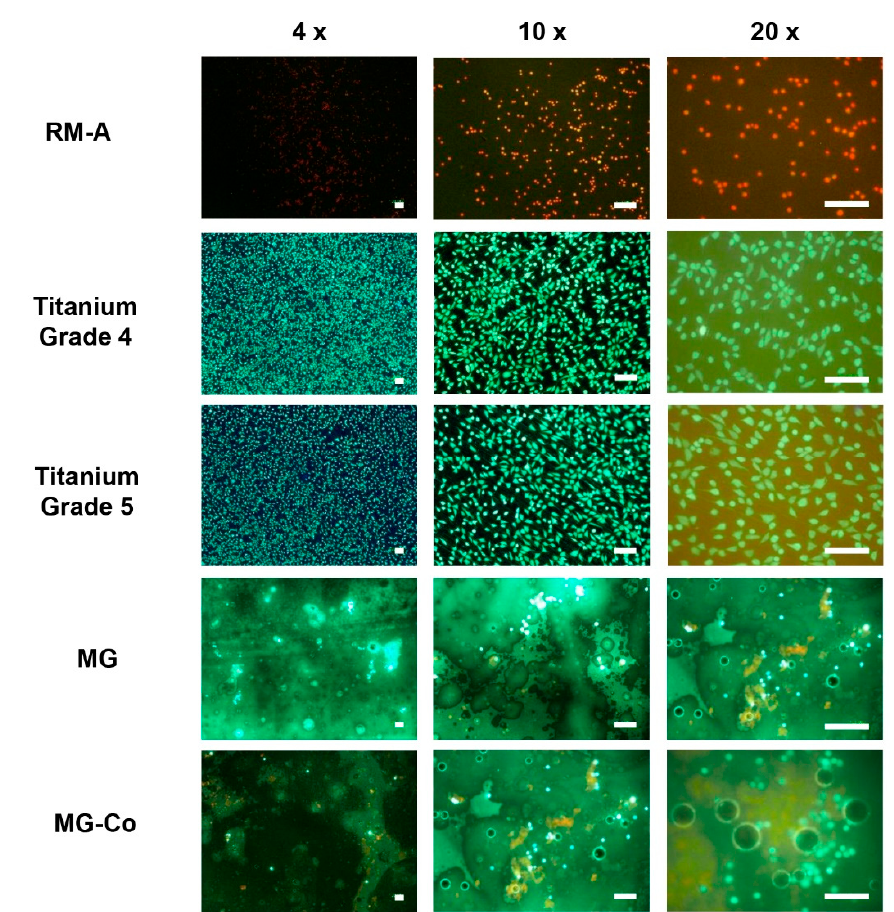
Figure 2. Live–dead staining of the test samples. Pure magnesium membrane = MG, coated magnesium membrane = MG-Co. Green: vital cells; red: dead cells (scale bars = 100 μ m).